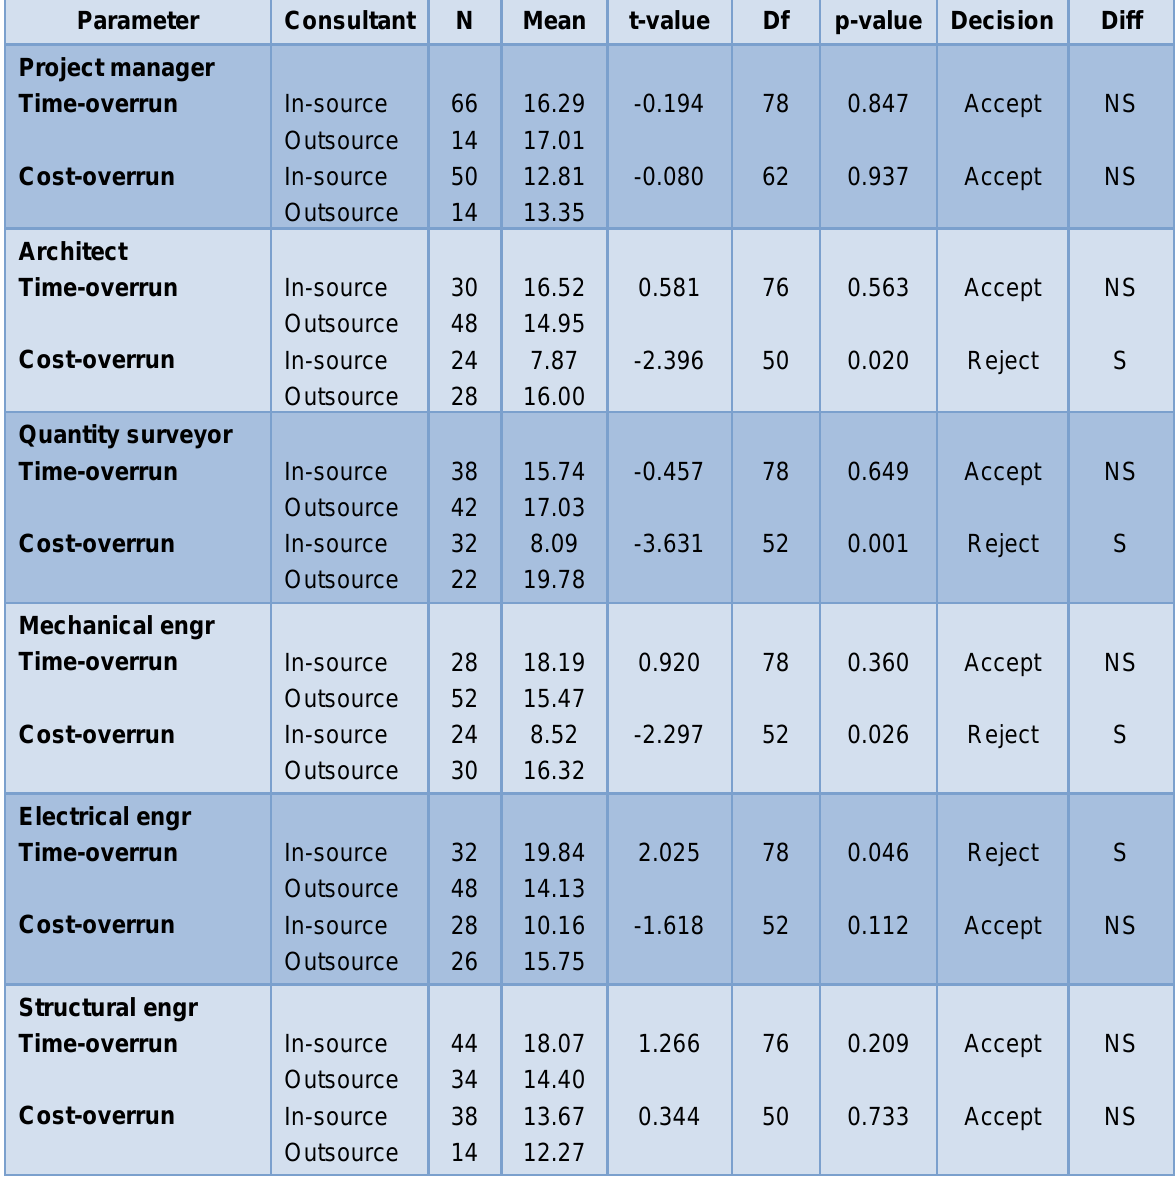
Table 5 Results of t-test of difference in project performance based on the use of in-sourced and outsourced consultants N=Number of respondents, Diff=Difference,